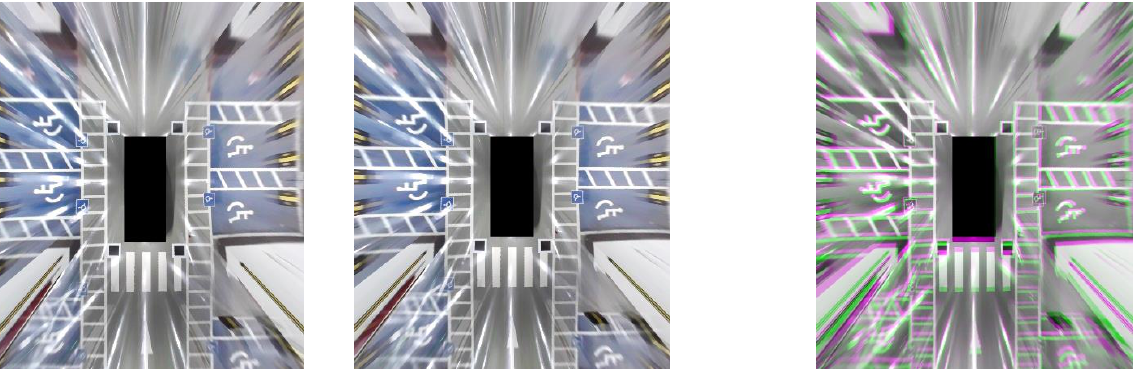
Figure 17. Experimental results of the proposed method and the conventional method. The magenta and green regions show where the grayscale intensities differ.